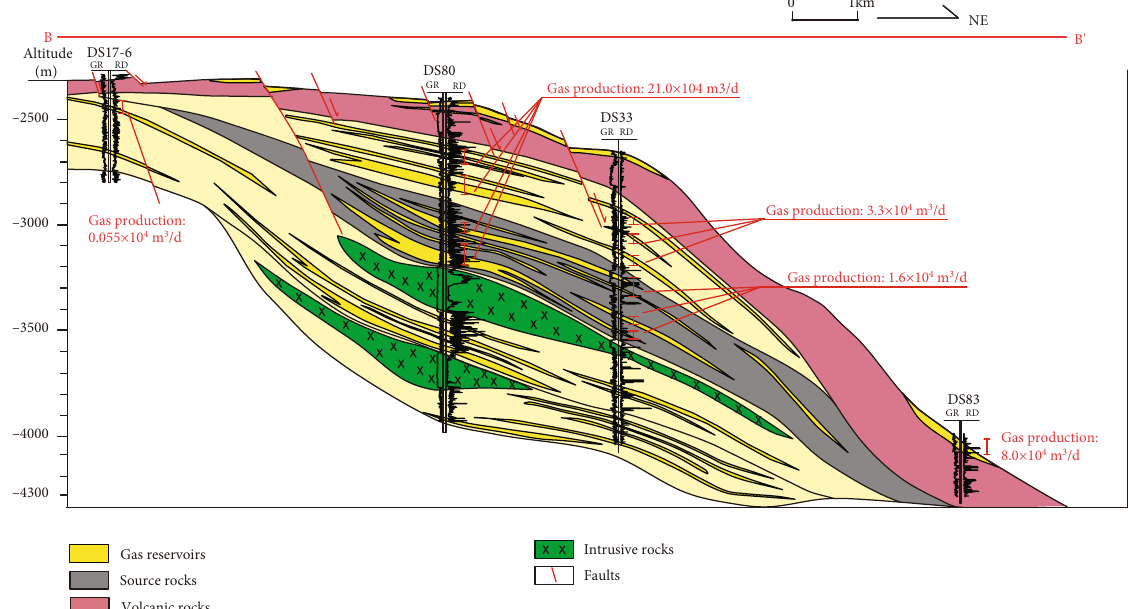
Figure 13: Cross-section of gas accumulation in the K yc; location of the pro fi le is shown in Figure 1. In this section, suitable gas productive 1 zones in the volcanic rock reservoir and tight sandstone reservoir are displayed (modi fi ed from [28]).